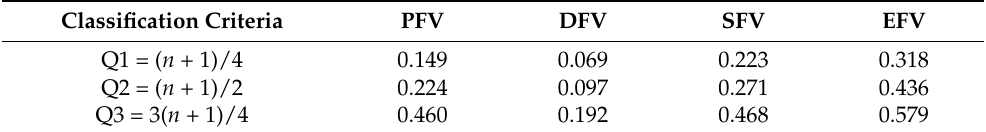
Table 2. Classification criteria for LUFs.